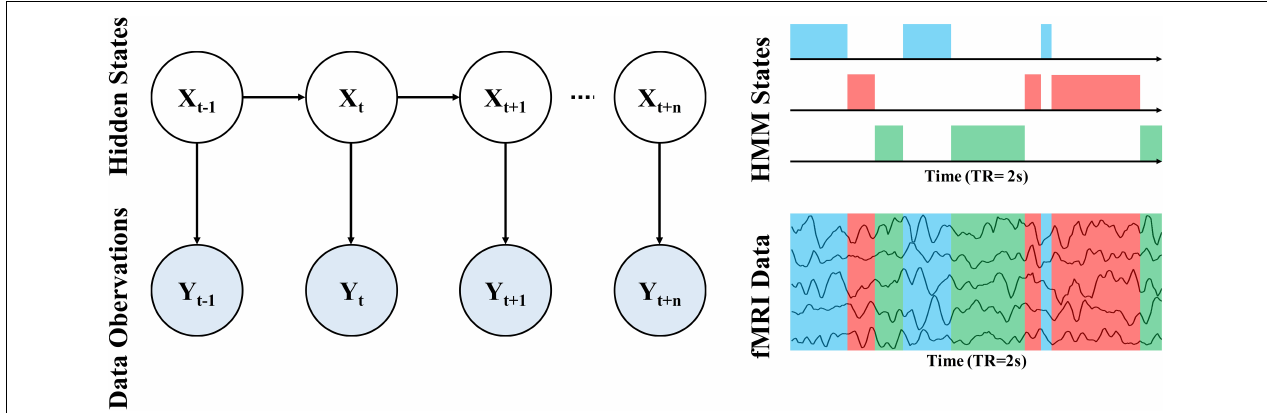
FIGURE 1 | Schematic illustration of the whole-brain dynamics using a Hidden Markov Model